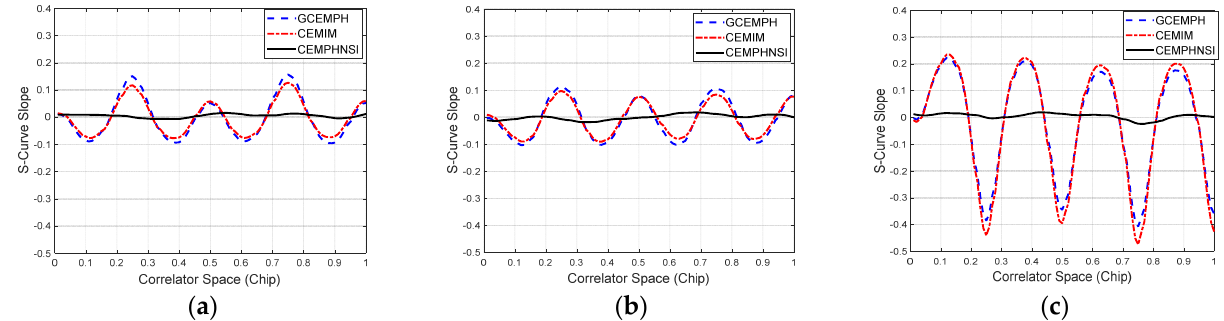
Figure 10. ( a ) The S-Curve slope of 3 multiplexing signals with signal s 1 ; ( b ) The S-Curve slope of 3 multiplexing signals with signal s 2 ; ( c ) The S-Curve slope of 3 multiplexing signals with signal s 3 .